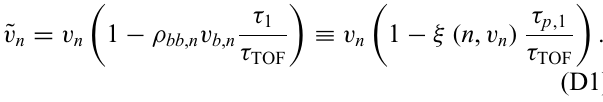
FIG. 10. (a) Numerical simulations for f R and f SDK versus Raman pulse area A R for different reflectivity r = | κ | 2 of the retroreflection mirrors. The red bars show estimated distribution of atoms subject to different pulse areas under the Gaussian beam illumination in this experiment. (b) n ( A R ) -weighted average f R and f SDK versus reflectivity r . The experimentally measured f R and inferred f SDK are marked with error